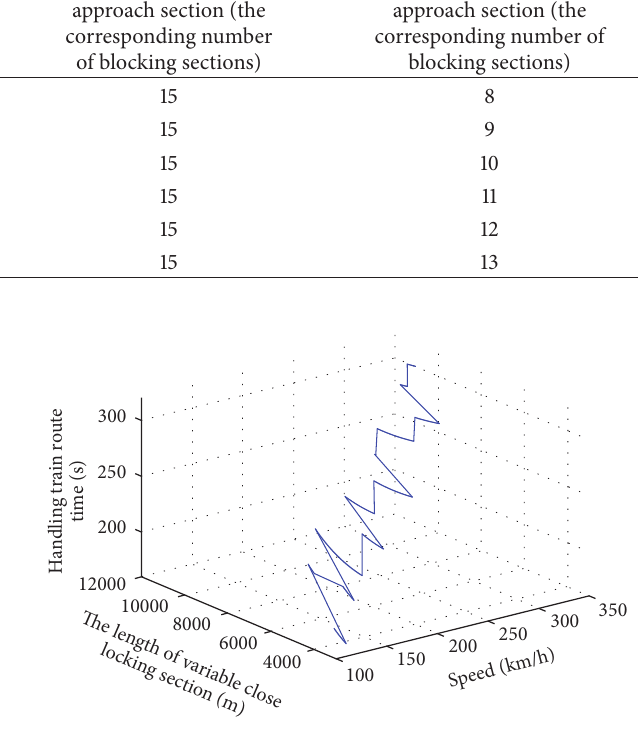
Figure 6: The relation curve space-time-speed for